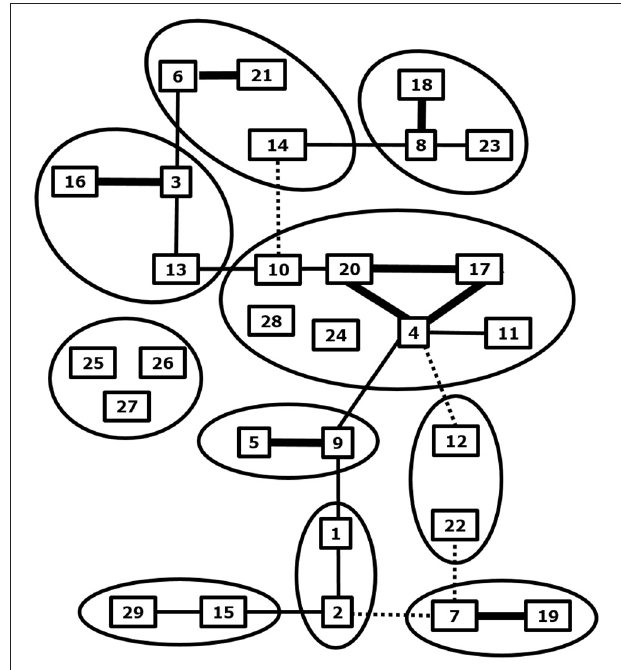
FIGURE 1 | Phylogenetic and neutralization relationship between BTV serotypes. Related BTV serotypes based on genome segment 2 expressing serotype specific immunodominant outer shell protein VP2 are grouped by circles. Cross neutralization between BTV serotypes is indicated by lines; strong (thick), some (normal) and weak neutralization (dashed). Adapted from Erasmus et al. ( 28), and Maan et al. (30) and updated for BTV27-29 from Bumbarov et al. ( 31), Wright (32), and Zientara